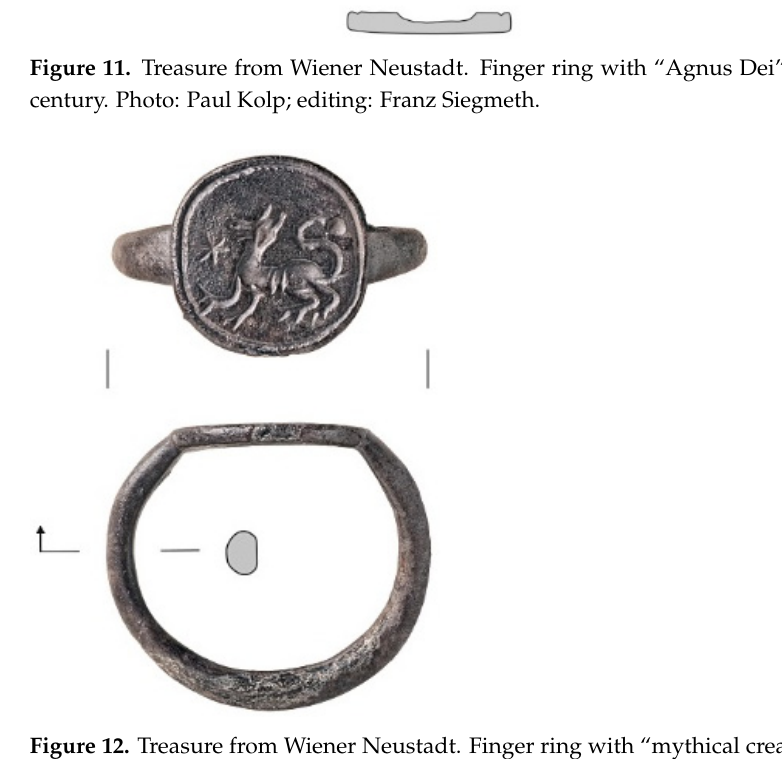
Figure 12. Treasure from Wiener Neustadt. Finger ring with “mythical creature” motif, 13th/14th century. Photo: Paul Kolp; editing: Franz Siegmeth.